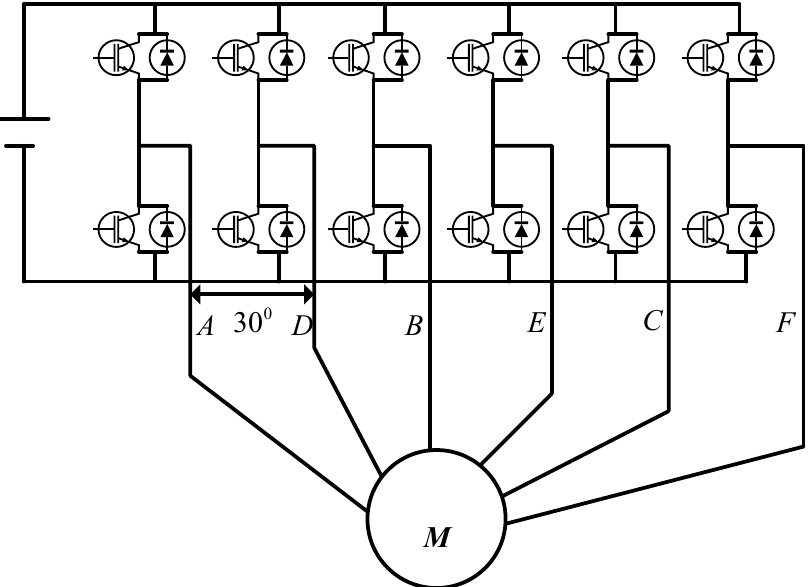
Figure 2. Drive system of asymmetric dual three-phase permanent magnet synchronous motor (ADT-PMSM).